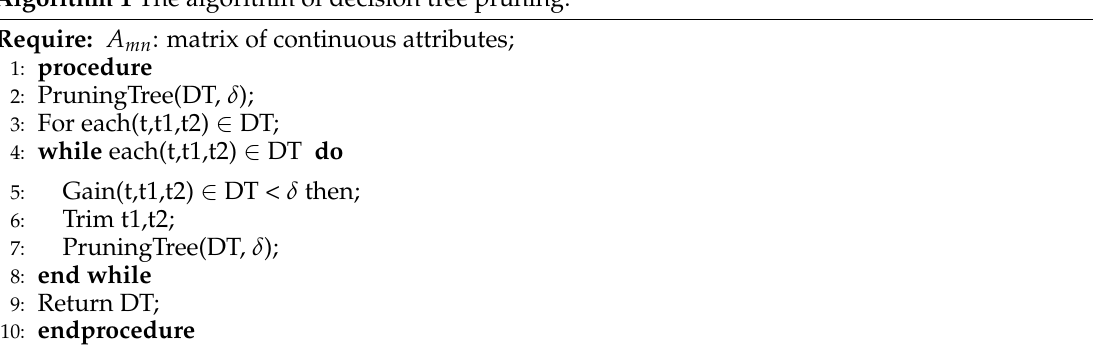
Algorithm 1 The algorithm of decision tree pruning.